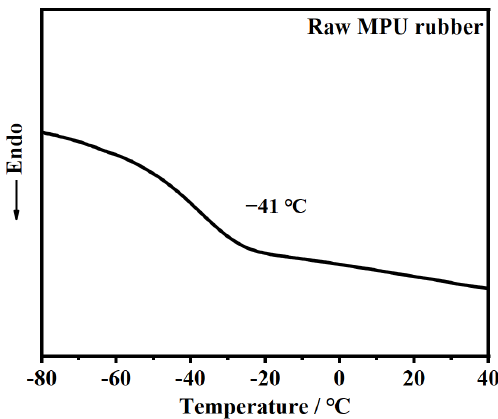
Figure 2. DSC curve of raw MPU rubber. The 1 H NMR spectra of 3MCPG, MDI, TME, and raw MPU rubber are shown in Figure 3. Peak a ( δ = 7.01–7.19 ppm) in the 1 H NMR spectrum of MDI corresponds to its benzene ring protons. Peak b ( δ = 5.10–5.27 ppm; –CH=) in the spectrum of TME corresponds to the protons belonging to its double bond, and peak c ( δ = 1.57–1.66 ppm; –CH 2 –) in the spectrum of 3MCPG corresponds to the protons on the methylene group not connected to the oxygen atom in the 3MCPG molecular chain.